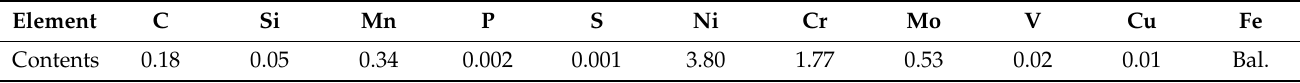
Figure 1. ( a ) The microstructure of the original sample. ( b ) X-ray diffraction of original sample.